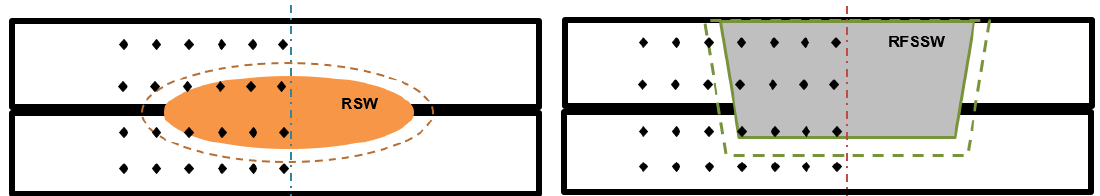
Figure 2. Scheme of microhardness indentations distribution in resistance spot welded (RSW) and refill friction stir spot welded (RFSSW) cross ‐ section.